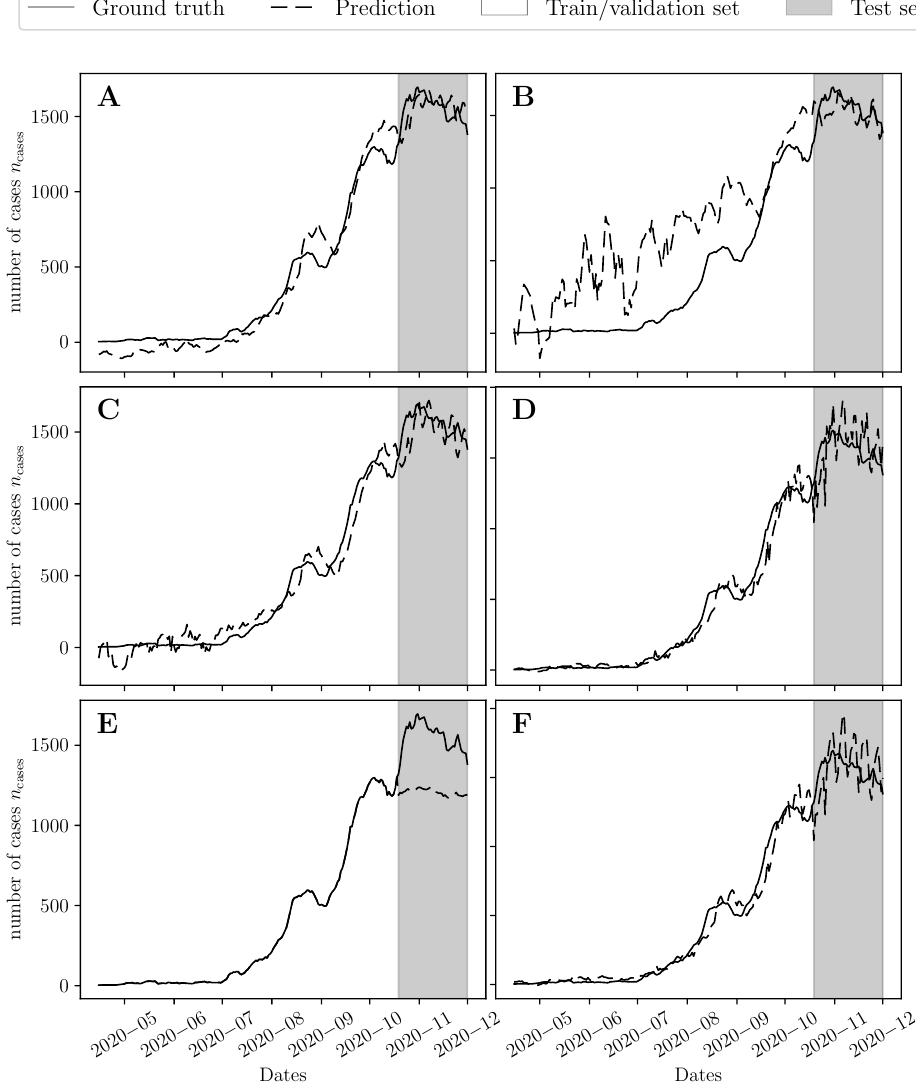
Figure 5. Predicted 7-day rolling average of daily number of cases on the unseen data set using ( A ) the sequence-to-sequence (S2S) model, ( B ) the stacked LSTM (SEQ), ( C ) The feedforward neural network (DNN), ( D ) The support vector machine regression (SVR) model, ( E ) The gradient boosting machine (GBM), and ( F ) the polynomial regression (OLS) model. All models were tuned using the cross-validation error of the discovery set. The grey shaded region represents the test data set (Group 2) used to test the models’